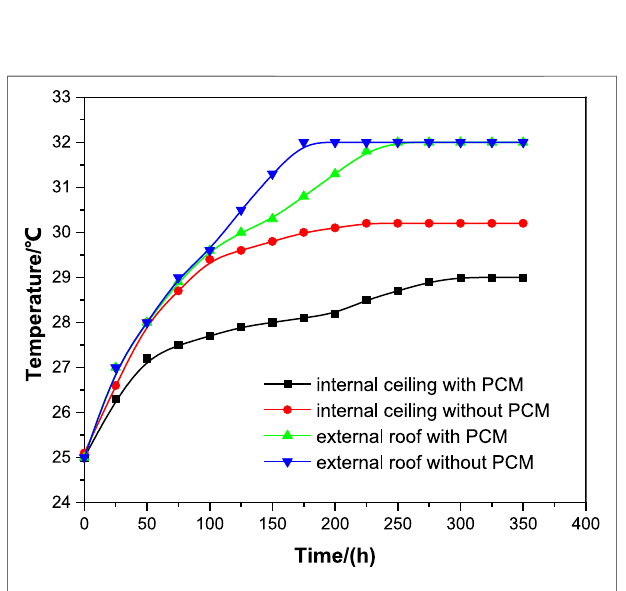
the reference model was basically the same, indicating that the heating conditions of the two models were basically the same during the experiment. However, there is obvious lag in the temperature rise of the PCM model due to the melting process of